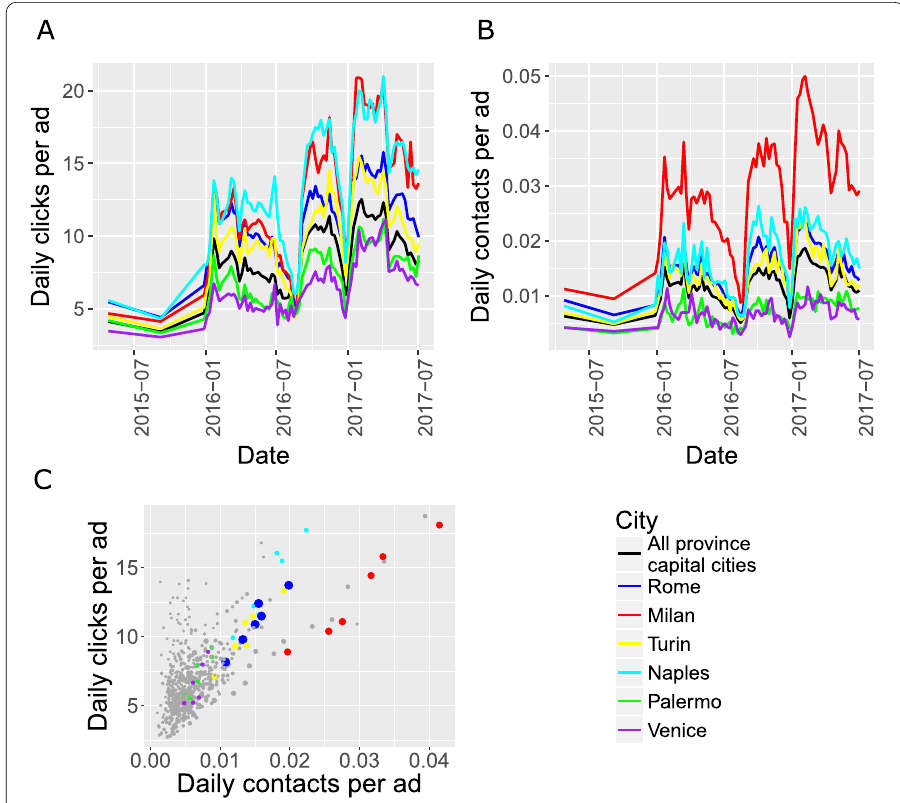
Figure 4 Clicks and contacts in the main Italian cities. ( A )–( B ) Temporal evolution of clicks and contacts in six cities and in the aggregate (solid black line). The time series are strongly cross-correlated and display seasonality. ( C ) Correlation between clicks and contacts. Each dot is a city in a quarter between 2016Q1 and 2017Q2. The size of dots is proportional to the number of visible ads, cities not shown in panels ( A )–( B ) are colored grey. The correlation coefficient is